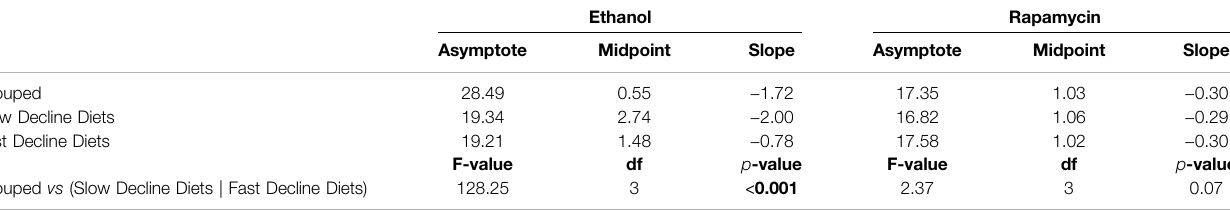
TABLE 3 | Comparison of coef fi cients for egg laying dynamics between Ethanol and Rapamycin treated fl ies. Diets were compared using self-starting logistics